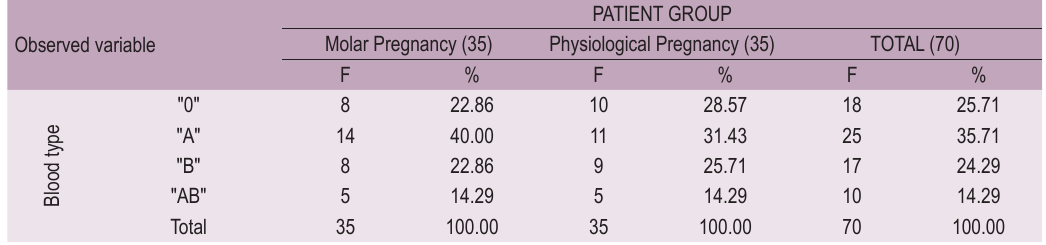
TABLE 7. Number and characteristics of patients according to the blood type